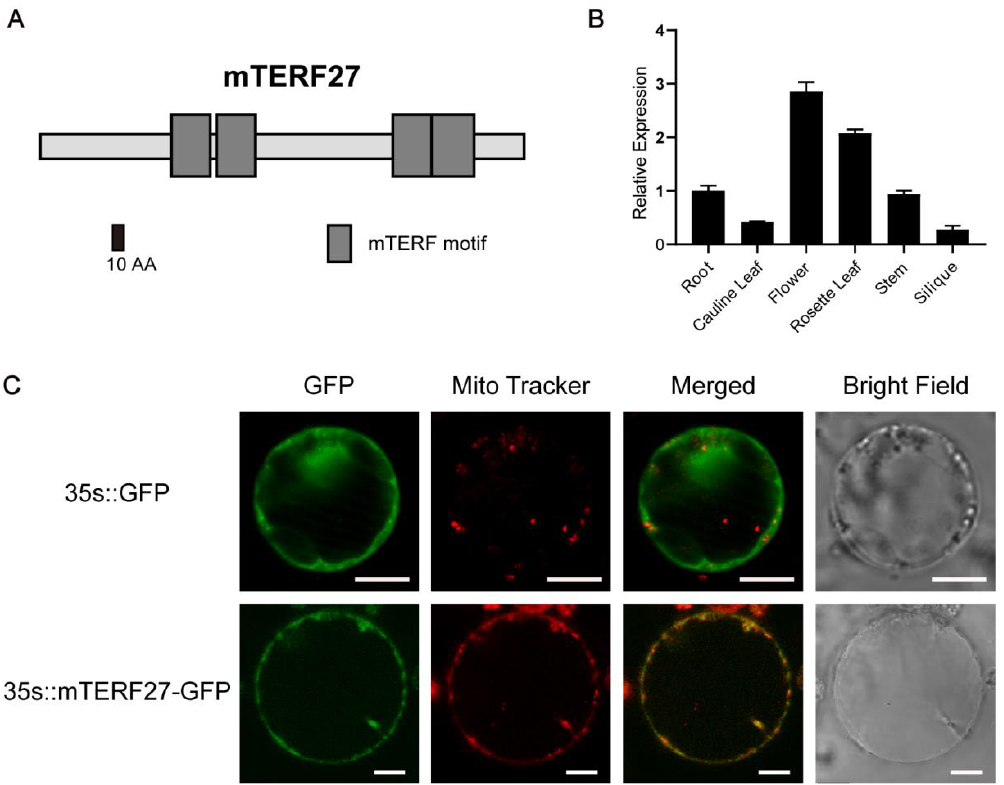
Figure 1. Modular architecture, expression pattern, and subcellular localization of mTERF27. ( A ) Schematic representation of the mTERF27 protein, drawn using SMART. mTERF motifs are shown as gray boxes. ( B ) Tissue-specific expression patterns of mTERF27, determined using qRT-PCR. Data are shown as means ± SD, n = 3. ACTIN2 was used as an internal control. ( C ) Transient expression of the vectors 35s::GFP and 35s::mTERF27-GFP in Arabidopsis protoplasts. Mitochondrial locations are shown using MitoTracker Red (Invitrogen). Scale bars = 10 μm.